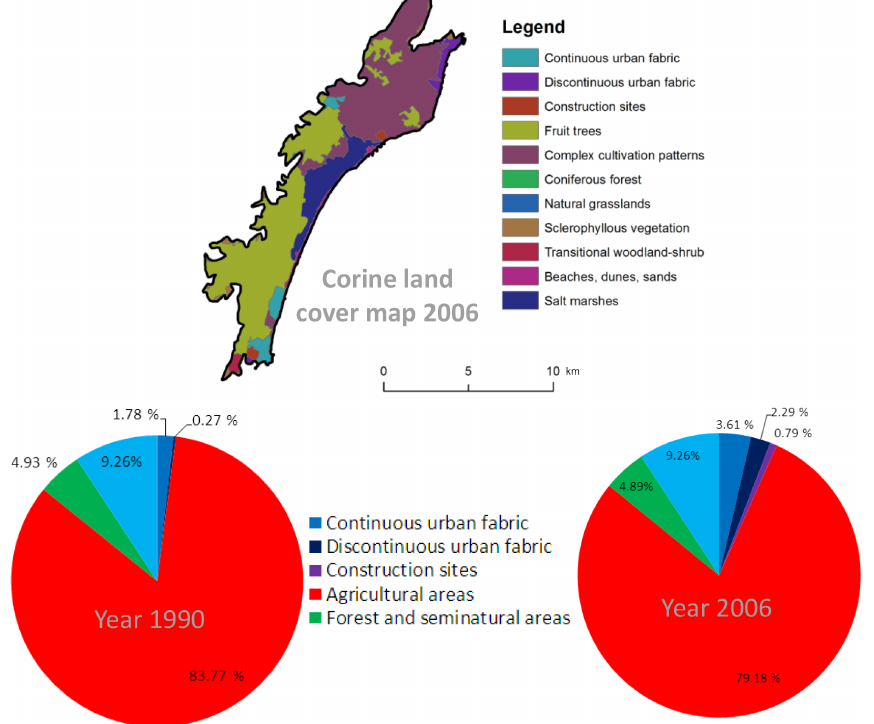
Figure 2. Land use change (comparing the CORINE Land Cover databases for 1990 and 2006) over the Plana Oropesa-Torreblanca and Maestrazgo